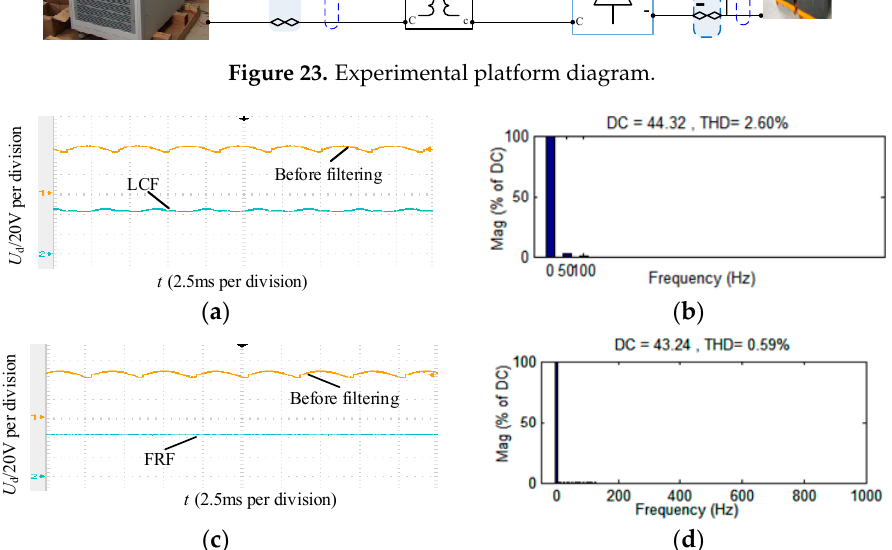
Figure 24. Filtering experiment results: ( a , b ) LCF and ( c , d ) FRF.